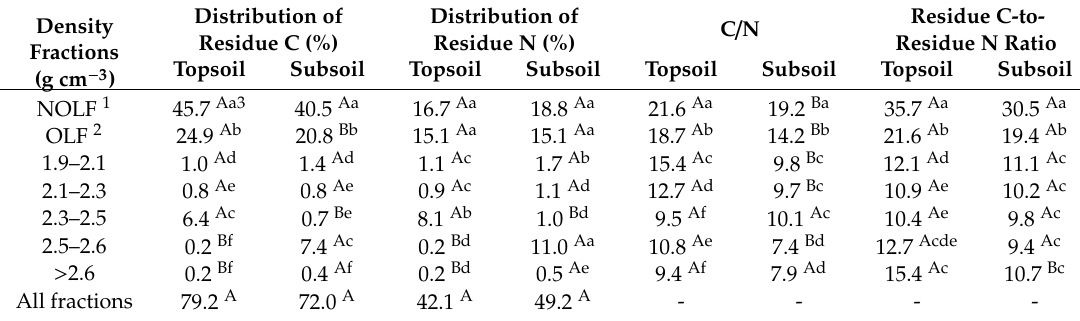
Figure 5. Proportions of ( a ) residue C and ( b ) residue N retained by the soil matrix in the form of mineral-associated organic matter (Residue C R-MAOM and Residue N R-MAOM , Equation (7)) in topsoil (0–20 cm) and subsoil (30–70 cm) from a heavy clay incubated for 51 d with 10 g C kg − 1 of 13 C- 15 N-labelled corn residues. * indicates significant difference at p < 0.05 between topsoil and subsoil. Table 1. Recovery of residue C and residue N, and C / N and residue C-to-residue N ratios in density fractions in topsoil (0–20 cm) and subsoil (30–70 cm) incubated with 10 g C kg − 1 soil of 13 C- 15 N-labeled corn residues for 51